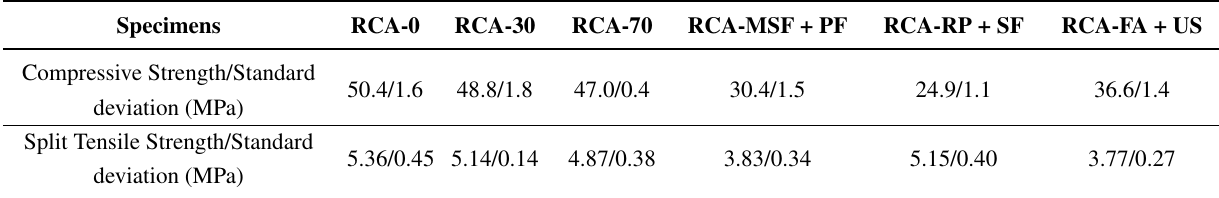
Table 6. The 28-day compressive strength and split tensile strength.